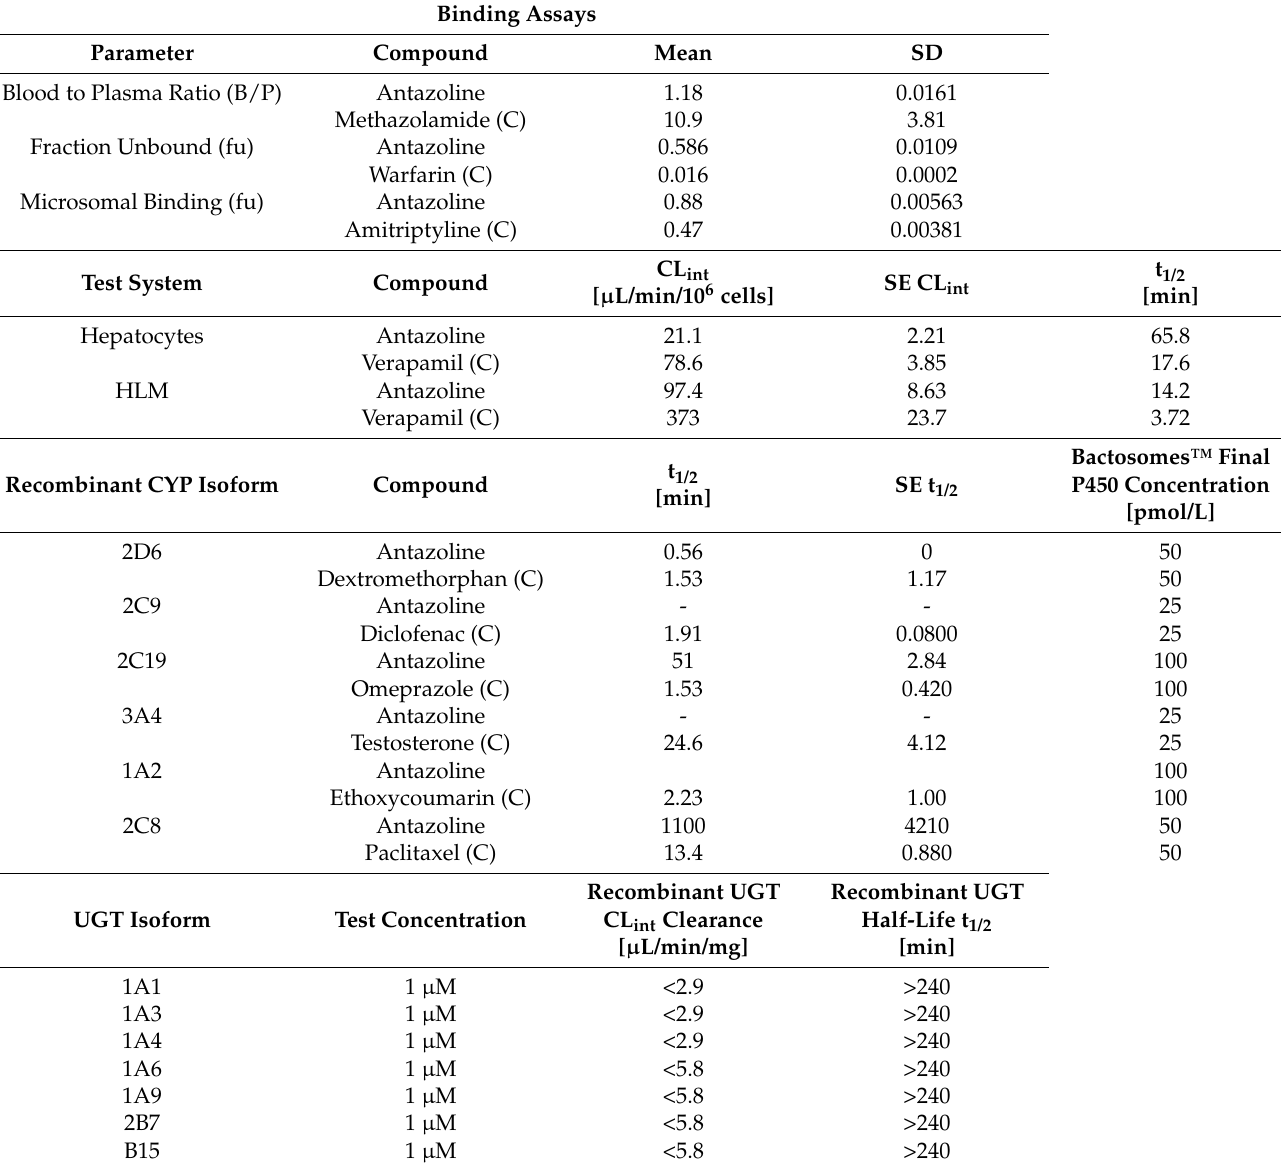
Table 1. Antazoline in vitro blood binding and metabolism